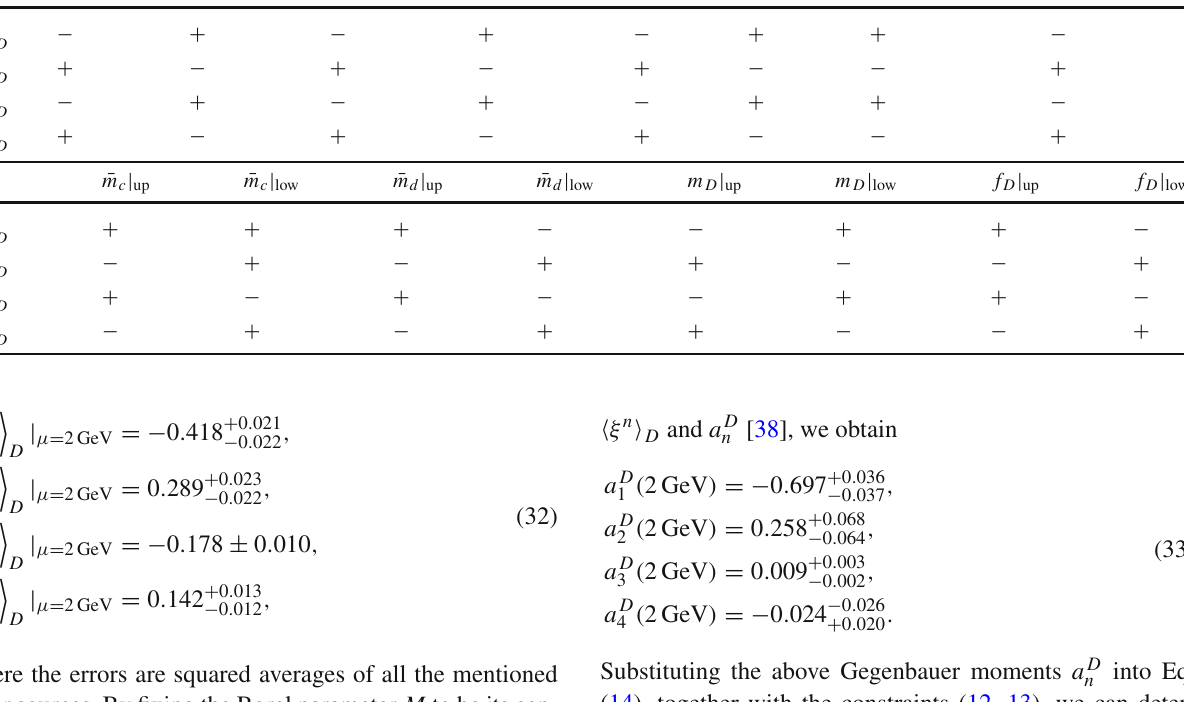
Table 4. Figure 5 is a comparison of φ 2 ; D , in which the solid, the dashed, the dash-dotted, the dotted and the thick dotted lines are for our present model (11), the Gegenbauer polynomial-like KLS model [23,24], the LLZ model [25], the Gaussian-type LM model [30] and the GH model